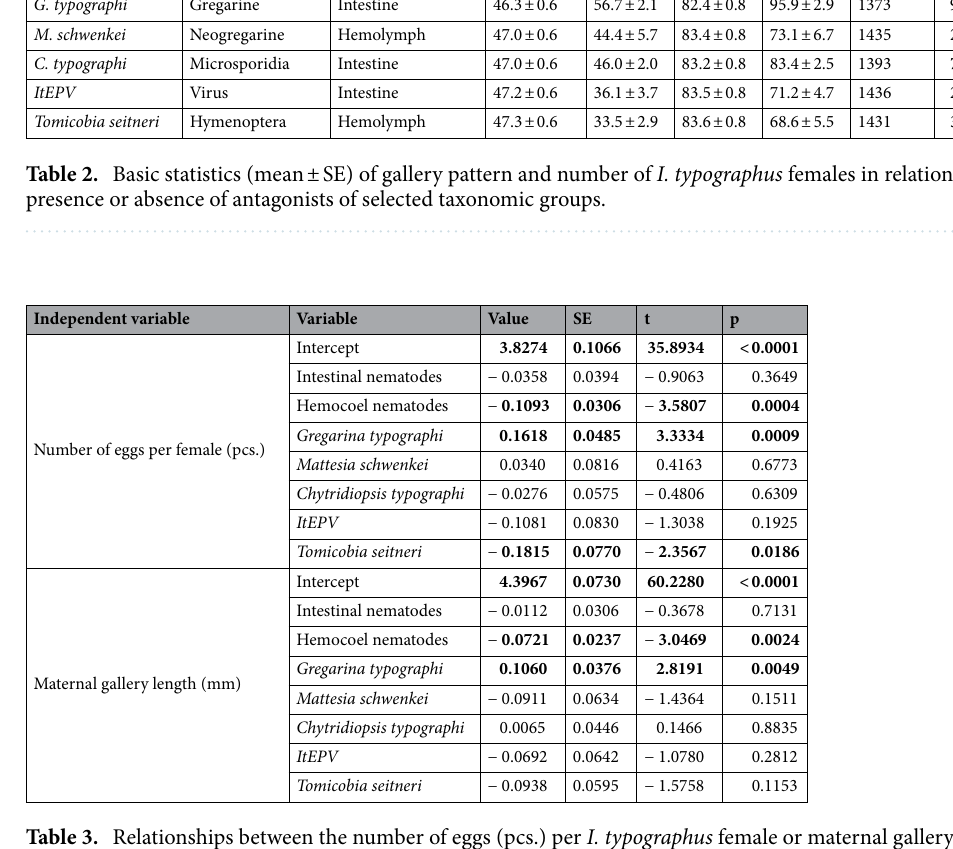
Table 3. Relationships between the number of eggs (pcs.) per I. typographus female or maternal gallery length (mm) and the presence of different groups of antagonists as indicated by GLMMs. Values in bold indicate a significant relationship at α = 0.05.